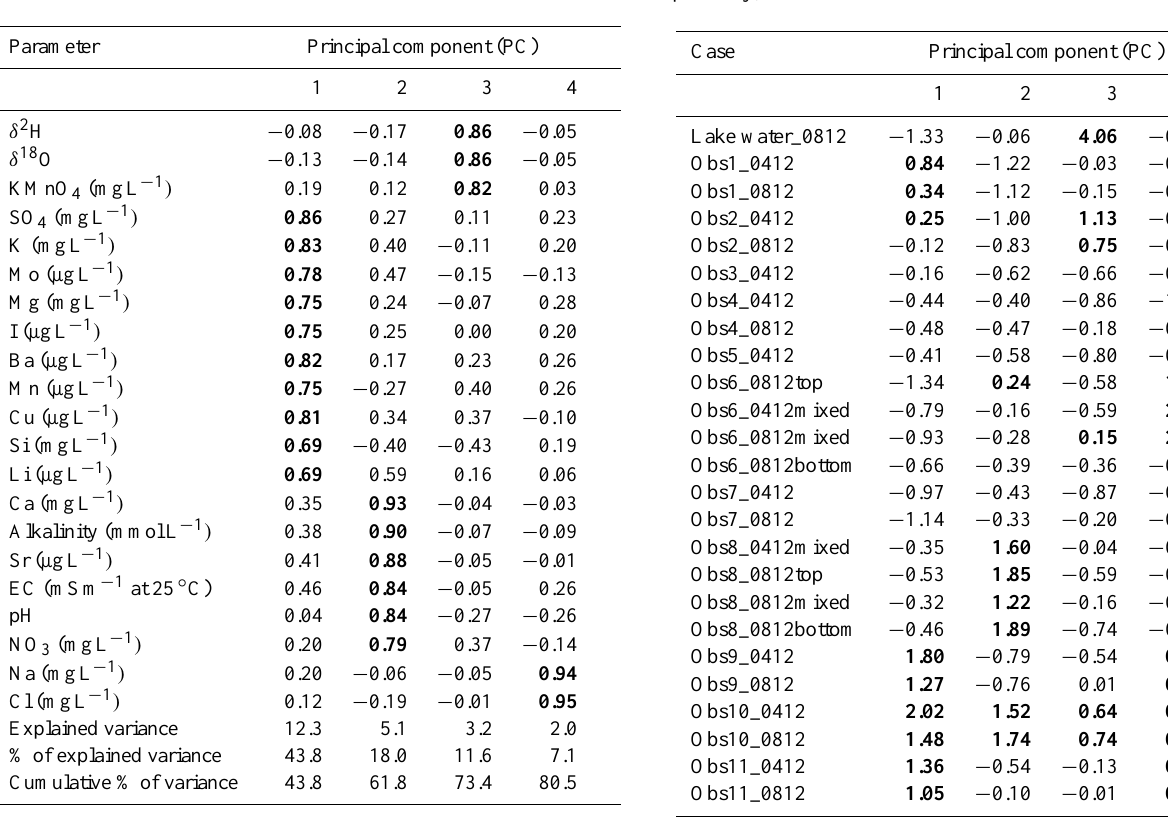
Table 3. Principal component loadings from factor analysis and ex- plained variances of geochemical variables and stable isotopes δ 2 H and δ 18 O of water samples. Factor loadings >0.7 are marked as bold.